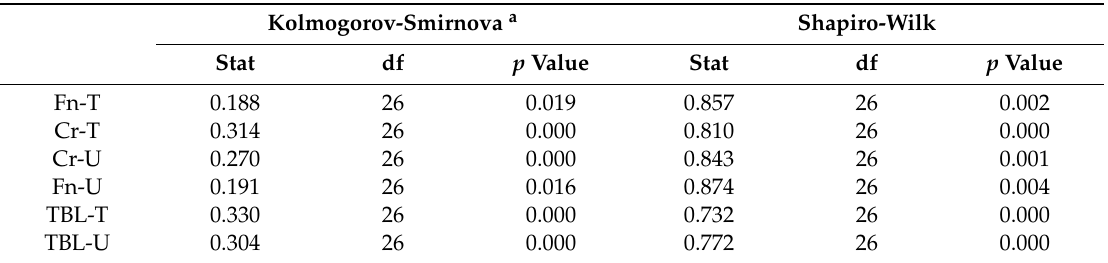
Table 3. Statistical analysis in order to verify the distribution of samples. a Lilliefors